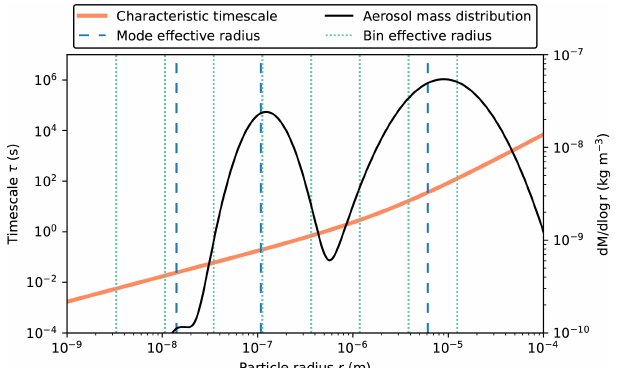
Figure 9. Comparison between timescale τ for effective radii used by the modal and sectional aerosol representation. For reference, the initial aerosol mass distribution is